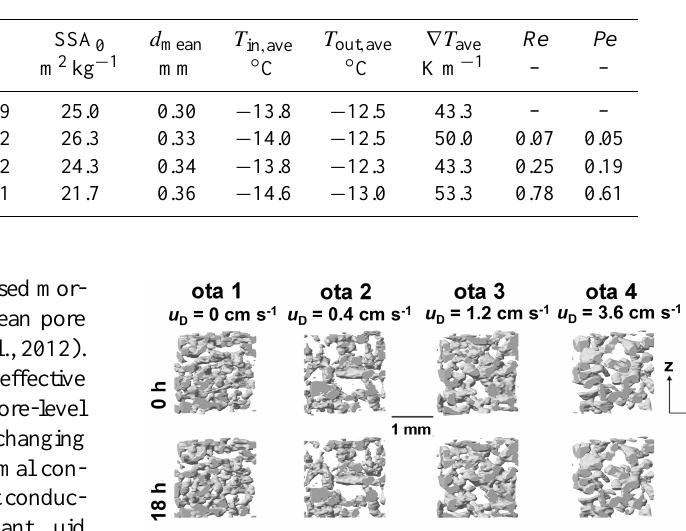
Table 1. Morphological and flow characteristics of the experiments: volume flow ( ˙ V ), initial superficial velocity in snow ( u D, 0 ), initial snow density ( ρ 0 ), initial porosity ( ε 0 ), specific surface area (SSA 0 ), initial mean pore size ( d mean ), average inlet ( T in , ave ) and outlet temperature ( T out , ave ), and the average temperature gradient ( ∇ T ave ), corresponding Reynolds number ( Re ) and Péclet number ( Pe ).